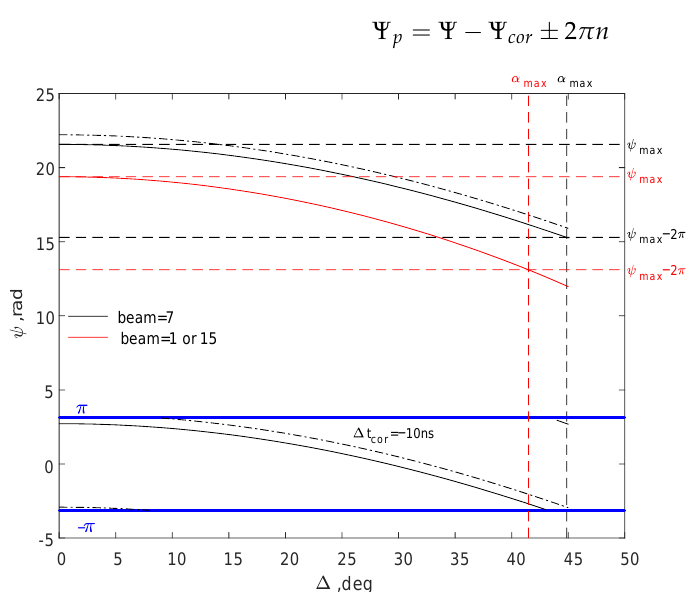
Figure 2. The relationship between the elevation angle and the phase difference for d = 100 m, f = 10.3 MHz (Zhongshan radar), the black line represents the boresight direction, and the red line represents the edge of the field of view. The solid blue horizontal line indicates that the phase difference is limited between − π and π measured by the radar when the ambiguity factor is not considered. The black and red horizontal dashed line represents the actual phase range Ψ max ∼ Ψ max − 2 π , and the black and red vertical dashed line represents the maximum elevation angle α max .